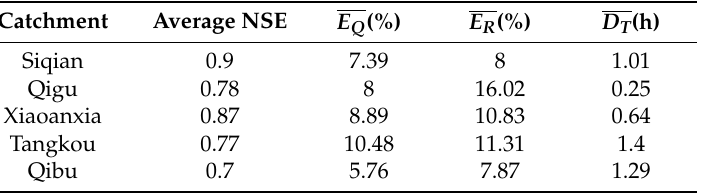
Table 3. Performances of the discharge simulations in data-rich catchments.